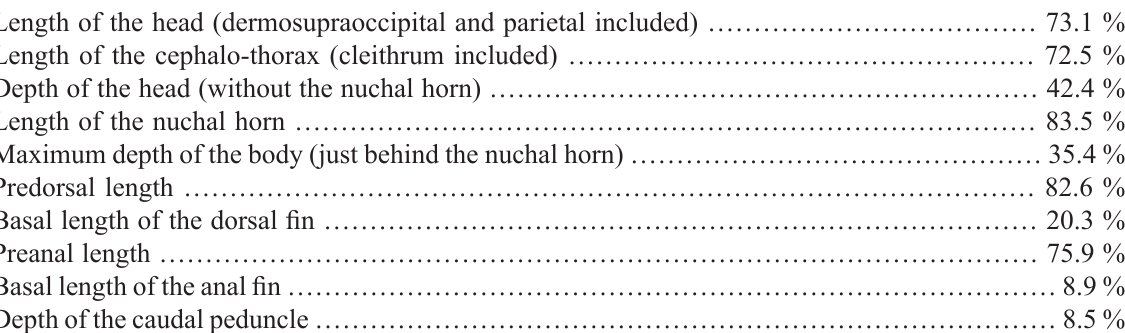
The morphometric data are given in % of the standard length of the holotype (36 mm).